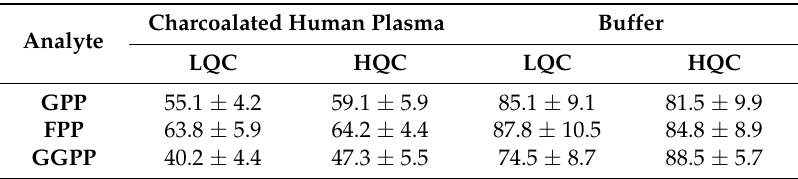
Table 3. Mean extraction recoveries (percentages, mean ± SD, n = 3) of GPP, FPP and GGPP from human plasma and cultured cancer cells.